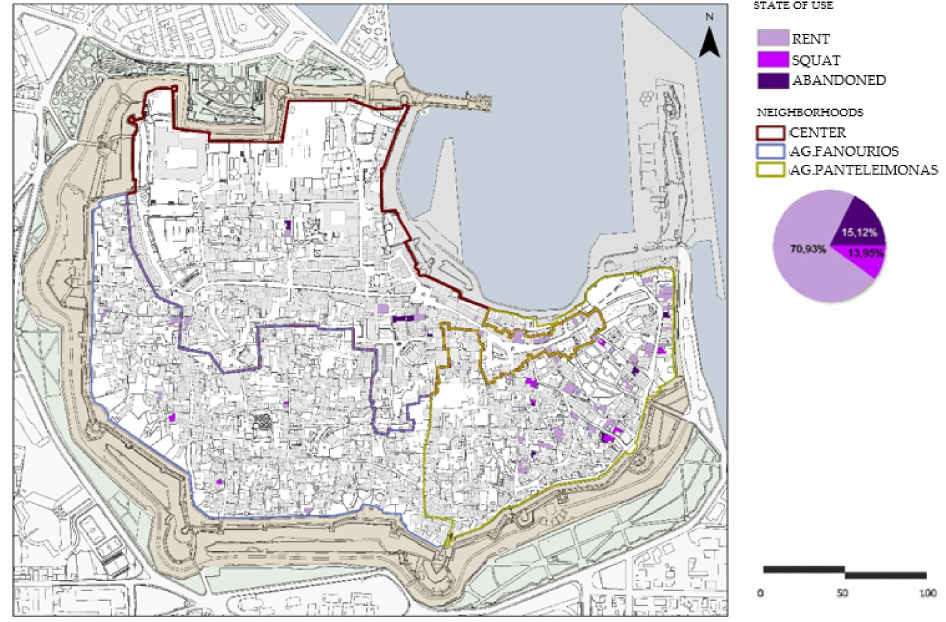
Figure 13. States of use (rent, abandoned,